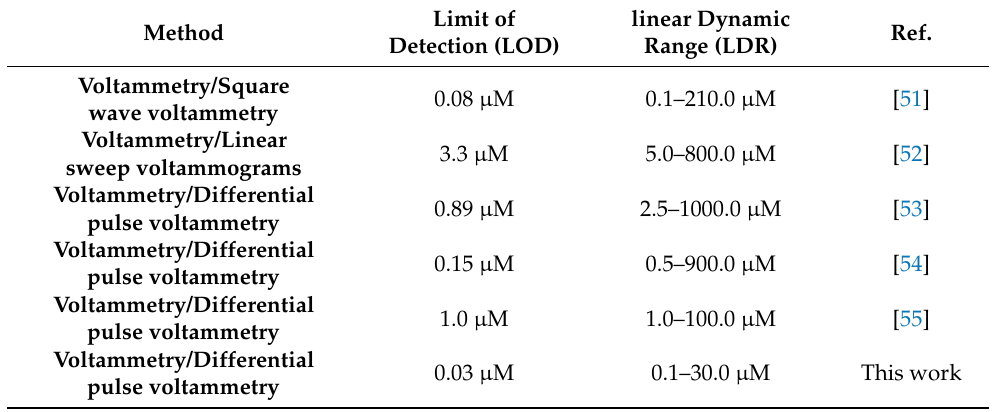
Table 2. Comparing the homocysteine aptasensor with existing electrochemical approaches previ- ously reported for homocysteine